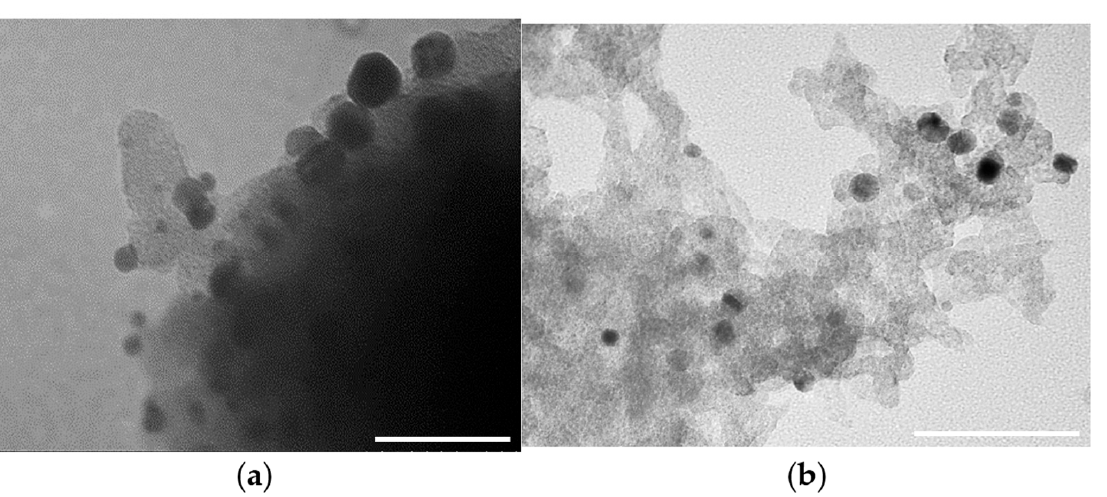
Figure 4. TEM micrographs of the ( a ) Au@meso-UiO-66- before-catalysis (scale bar is 100 nm) and ( b ) Au@meso-UiO-66-after-catalysis (scale bar is 50 nm) nanohybrid s.